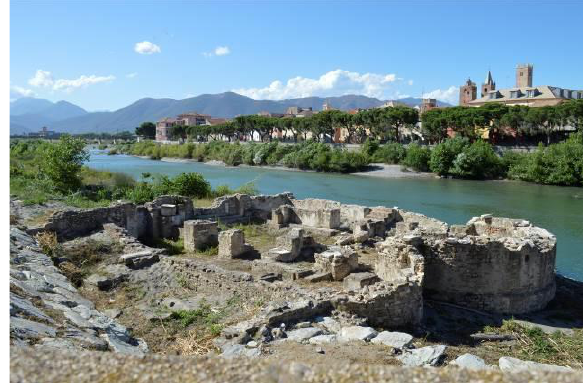
Figure 1. Church of San Clemente, Albenga,